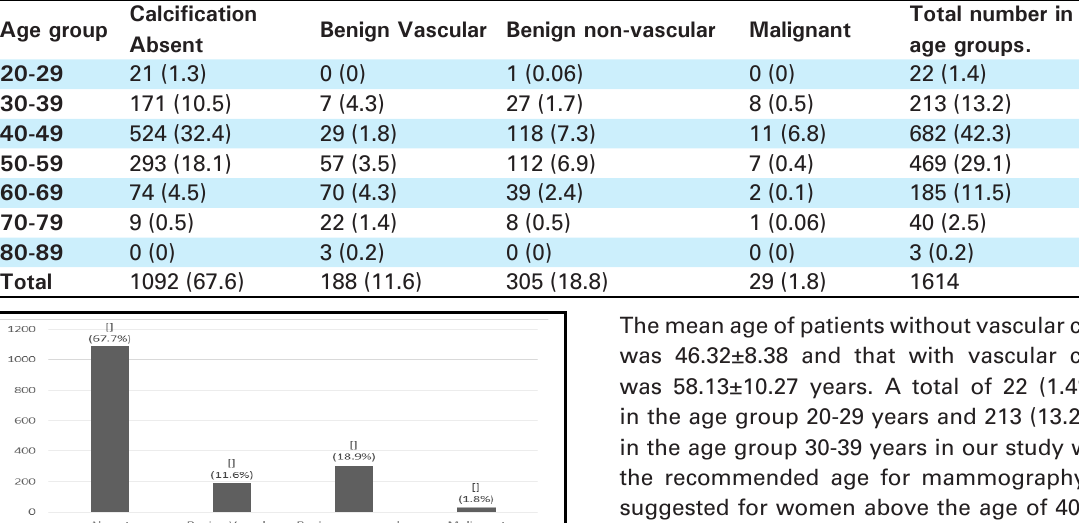
Figure 1. Overall distribution of different types of calcifications in